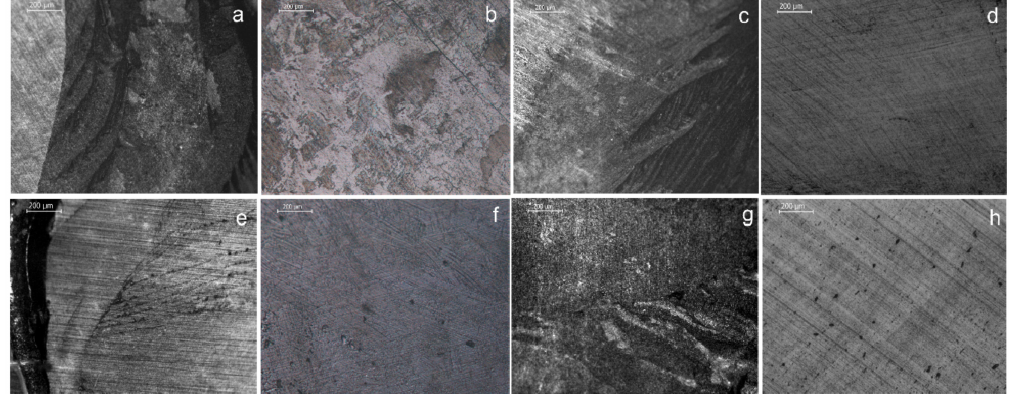
Figure 9. Representative reflected-light microscopic images of debonded ceramic surfaces (50 × , bar = 200 µ m) demonstrating Type III (mixed) failures with a great part of ceramic surface coverage by resin ( a , c , g ), Type III failures with minimal resin coverage ( b , e ) and Type I (adhesive) failures ( d , f , h